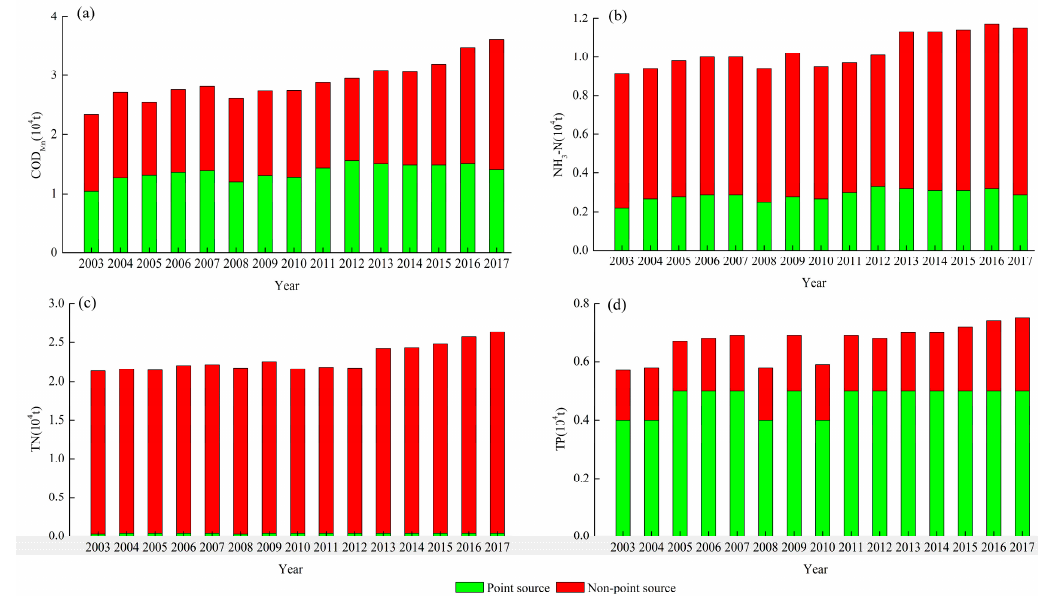
Figure 5. Temporal variation of annual load of four main pollutants, ( a ) COD Mn , ( b ) NH 3 -N, ( c ) TN, and ( d ) TP, discharged to the river water of the Lixiahe abdominal area.